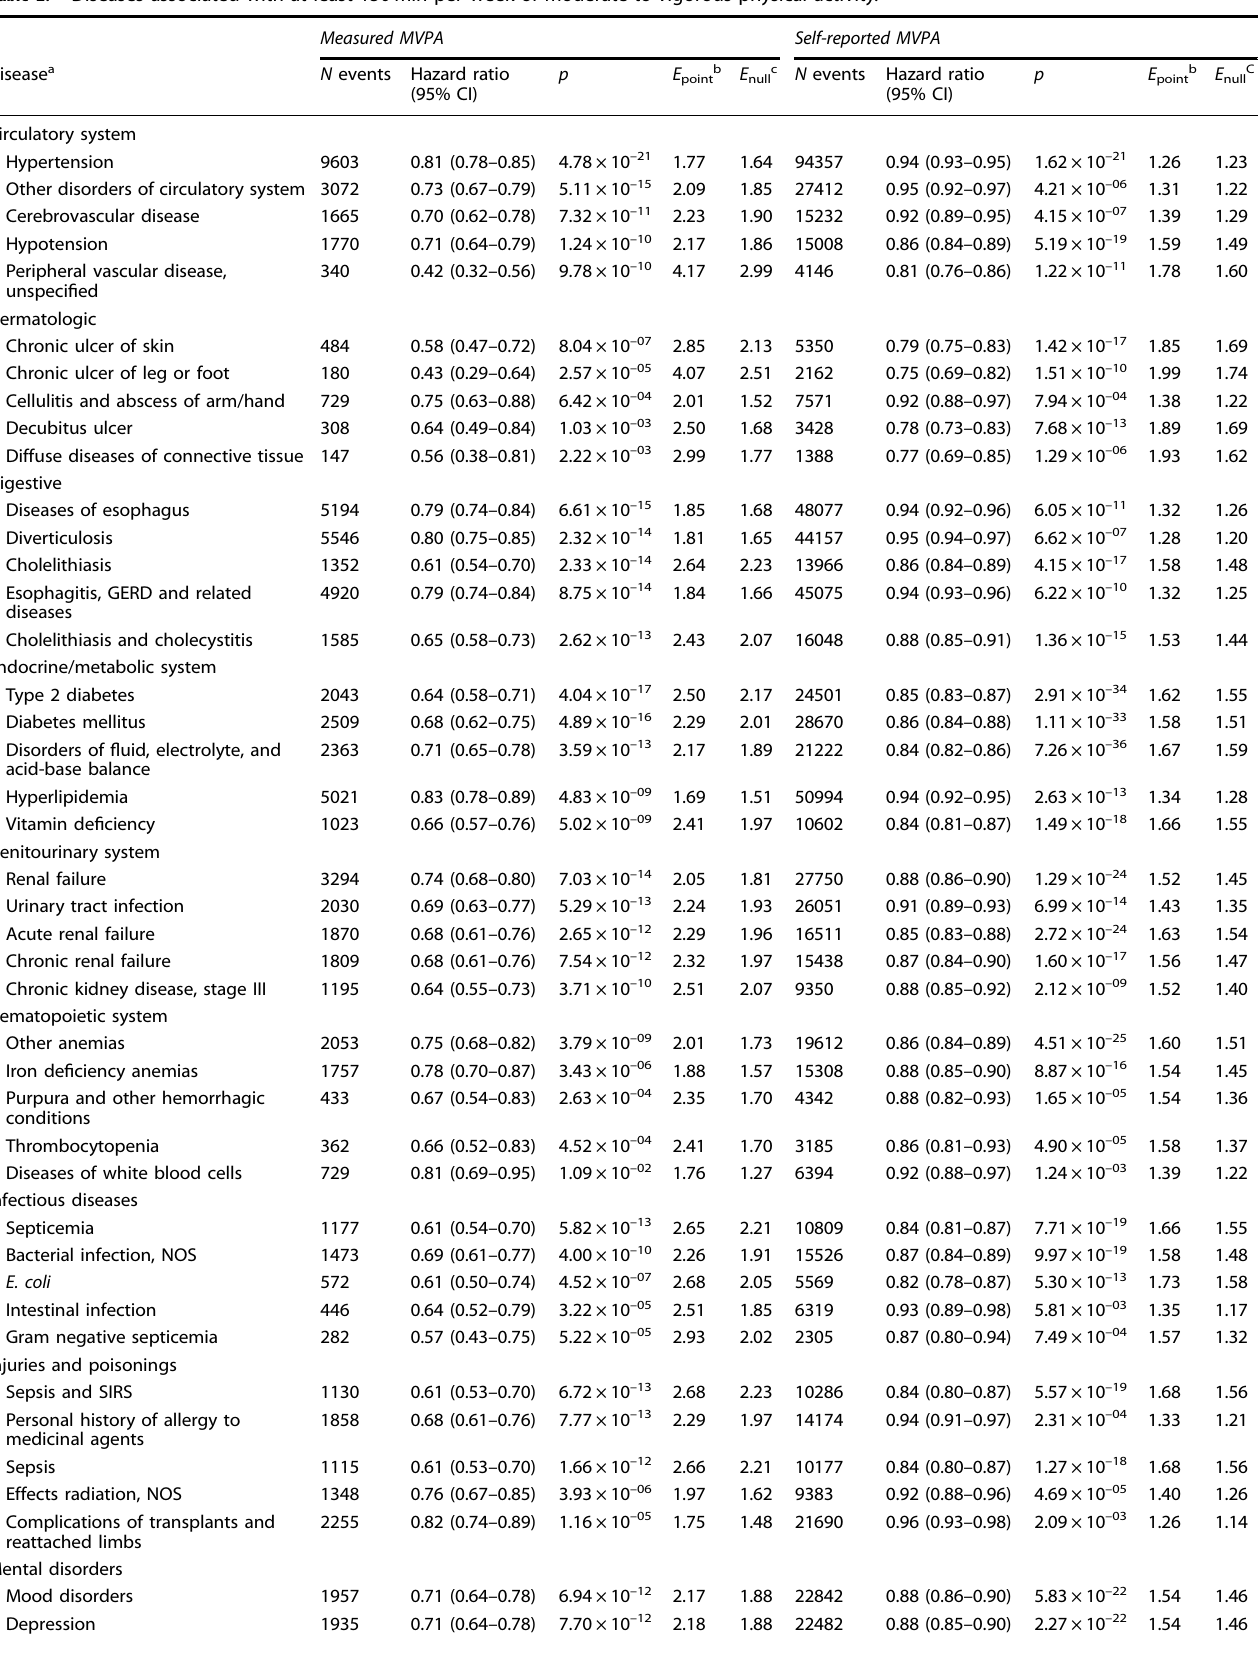
Table 2. Diseases associated with at least 150 min per week of moderate-to-vigorous physical activity. Measured